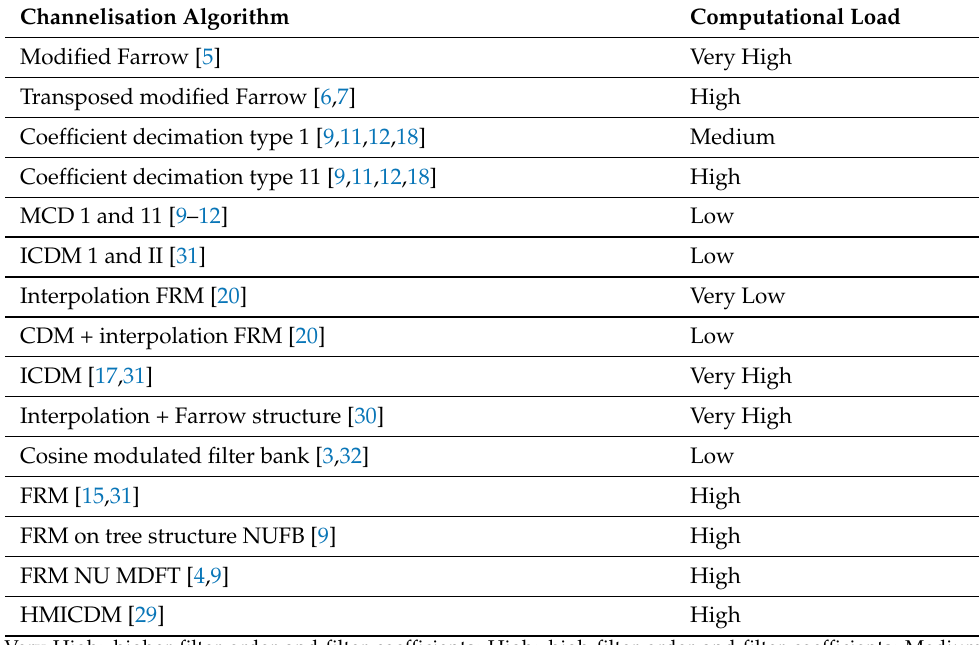
Table 1 recaps the comparison study of the different channelisation algorithms. Table 1. Comparison study of the different channelisation algorithms. Channelisation